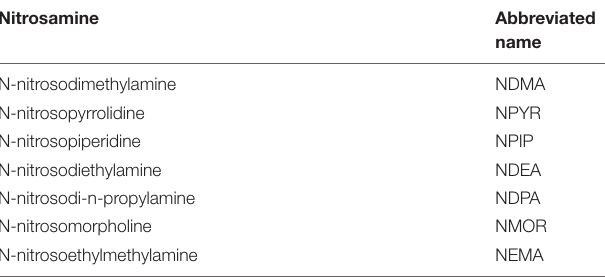
TABLE 2 | Main nitrosamines occurring in meat products.